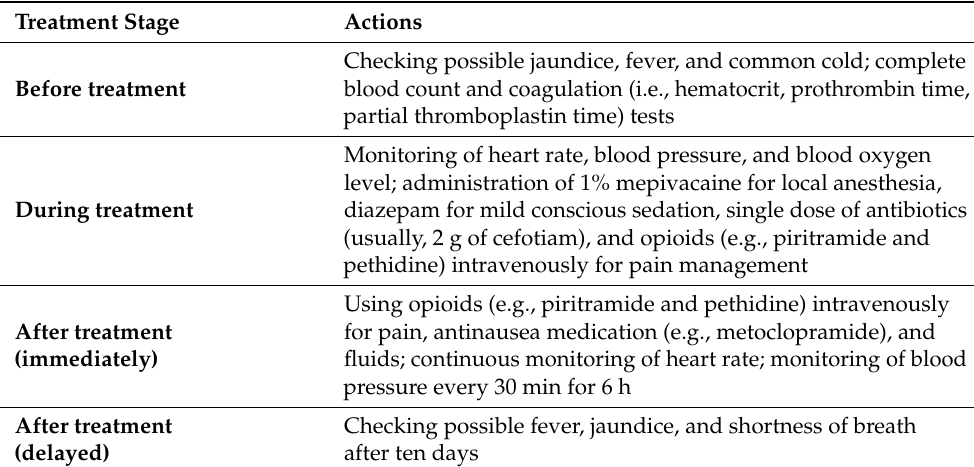
Table 3. Safety parameters used before, during, and after treatment. Reproduced with permission from